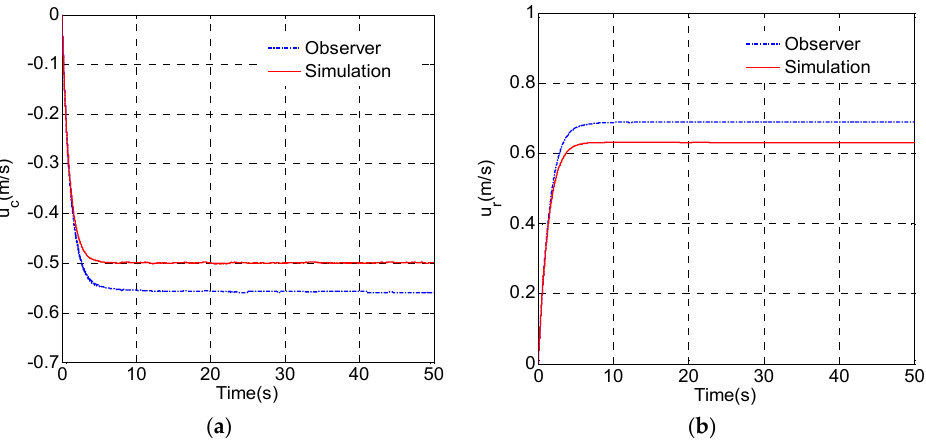
Figure 13. Observed result of velocity: ( a ) current velocity in the X direction; ( b ) relative velocity of ROV in the x direction.